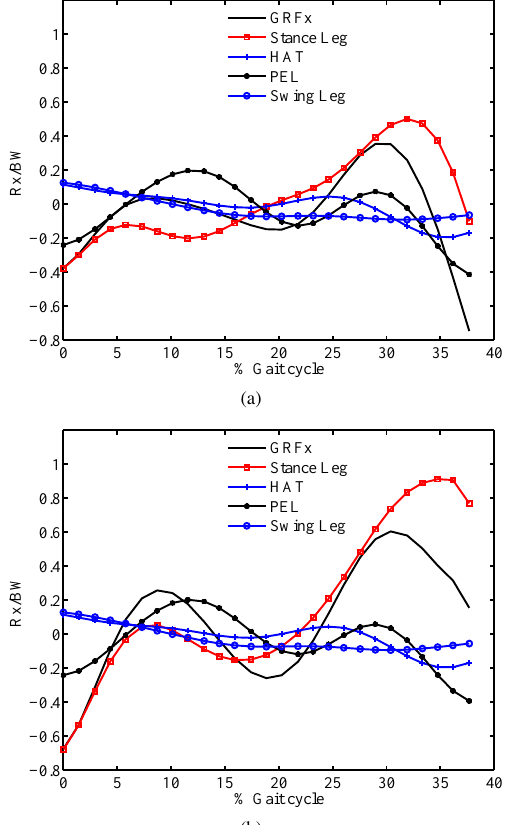
Figure 7. GRFx and stance leg, HAT, pelvis and swing leg contri- butions to GRFx during SS phase as a fraction of body weight with (a) AFROS and (b) FROS. (Gait cycle starts at toe-off of the other leg, that is, at the beginning of SS.)